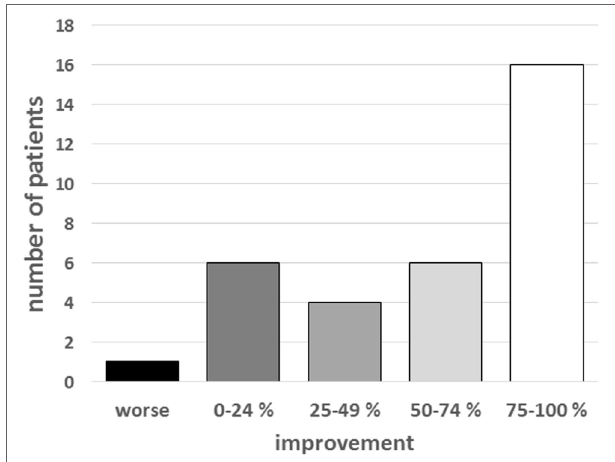
FigUre 2 | Patient distribution according to the degree of improvement on day 3. The chart represents the numbers of patients who were improved by > 75, 50–75, 25–50, and < 25%.